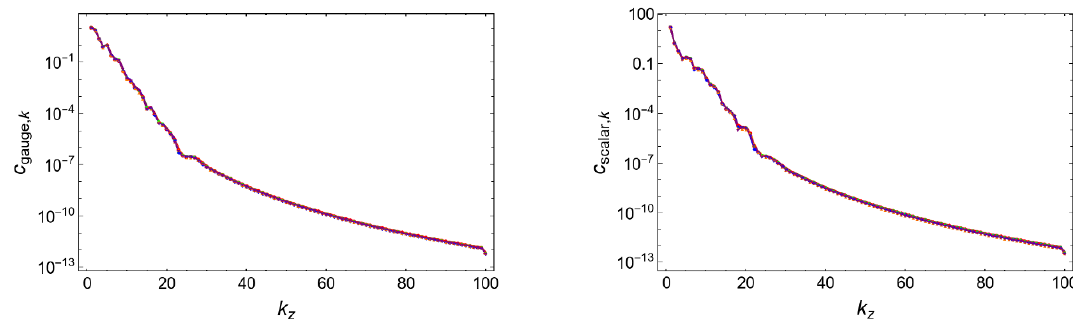
Figure 12 . Example coe(cid:14)cient convergence plot for the gauge (cid:12)eld (left) and scalar (cid:12)eld (right) for (cid:12)ve randomly chosen samples at M = 10 : 1, (cid:22) (cid:13) = 0 : 45, A M 0 = 0 : 1, b off = 1 : 0: maximum Chebyshev absolute coe(cid:14)cient as a function wave number k z , where the maximum is taken over the remaining x -direction.